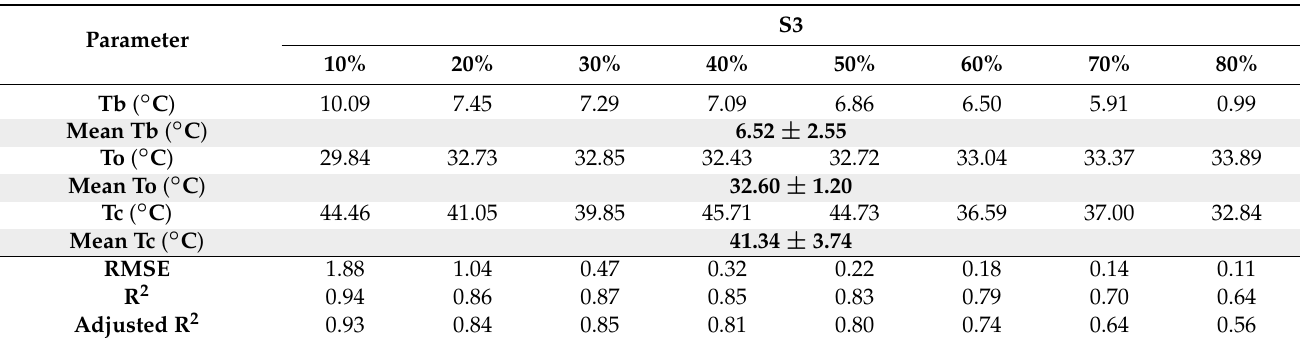
Table 5. Estimated parameters for segmented models (S3) of Salvia hispanica seeds. Root mean square of deviations (RMSE) and coefficient of determination (R 2 ) for the relationship between emergence